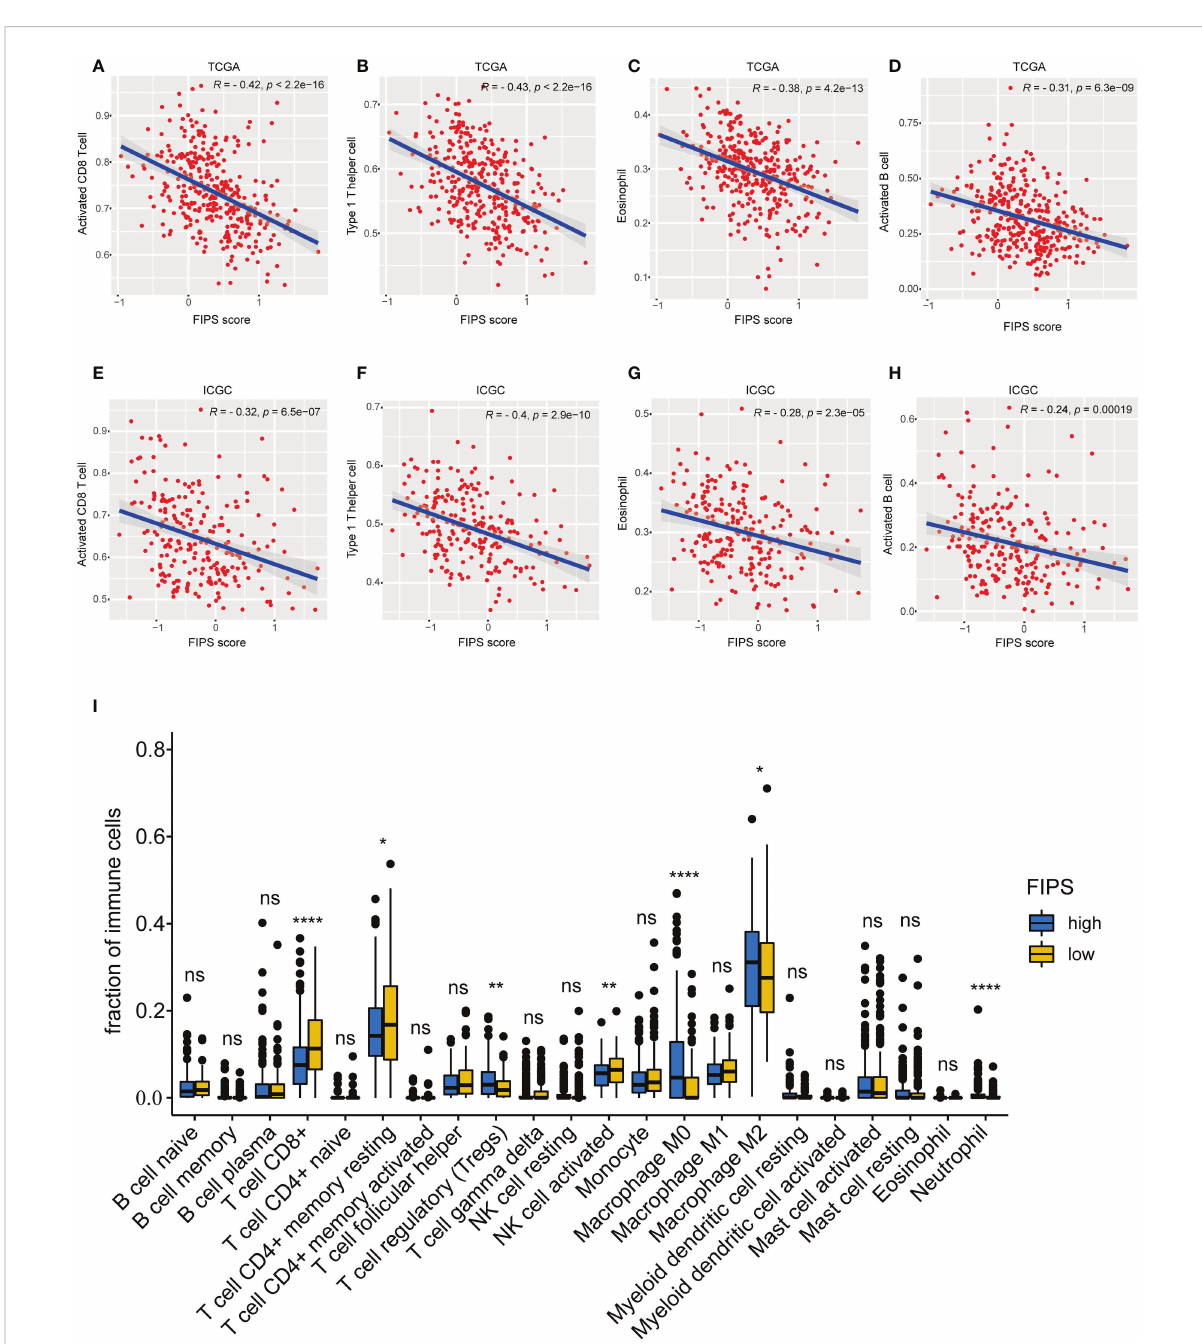
FIGURE 7 (A – H) single-sample Gene Set Enrichment Analysis (ssGSEA) and correlation analysis of the FIPS score and the immune enrichment scores of immune categories in the TCGA and ICGC cohorts. (I) Comparison between the fractions of immune cells in the high- and low-FIPS subgroups of the TCGA cohort via the CIBERSORT method. * p < 0.05; ** p < 0.01; **** p <